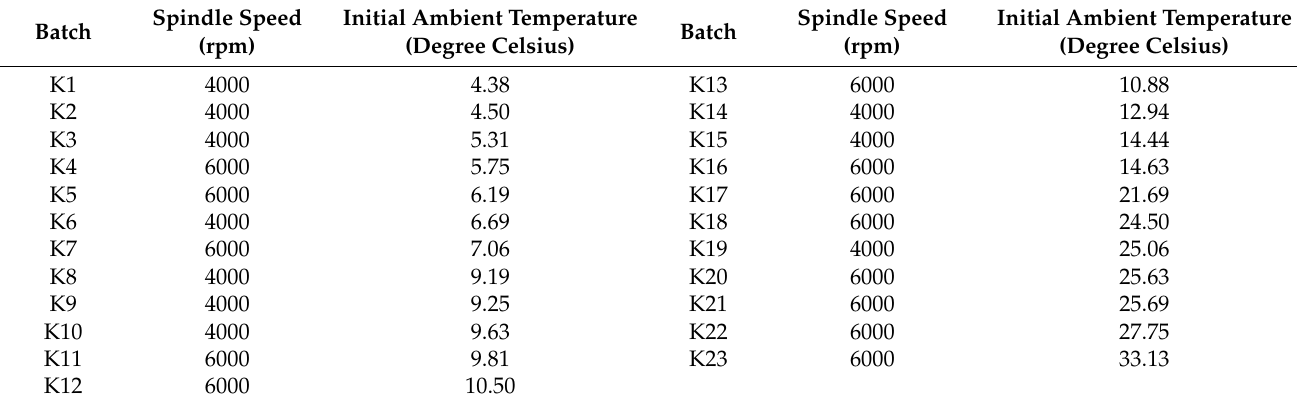
Table 2. Experimental conditions for each batch of